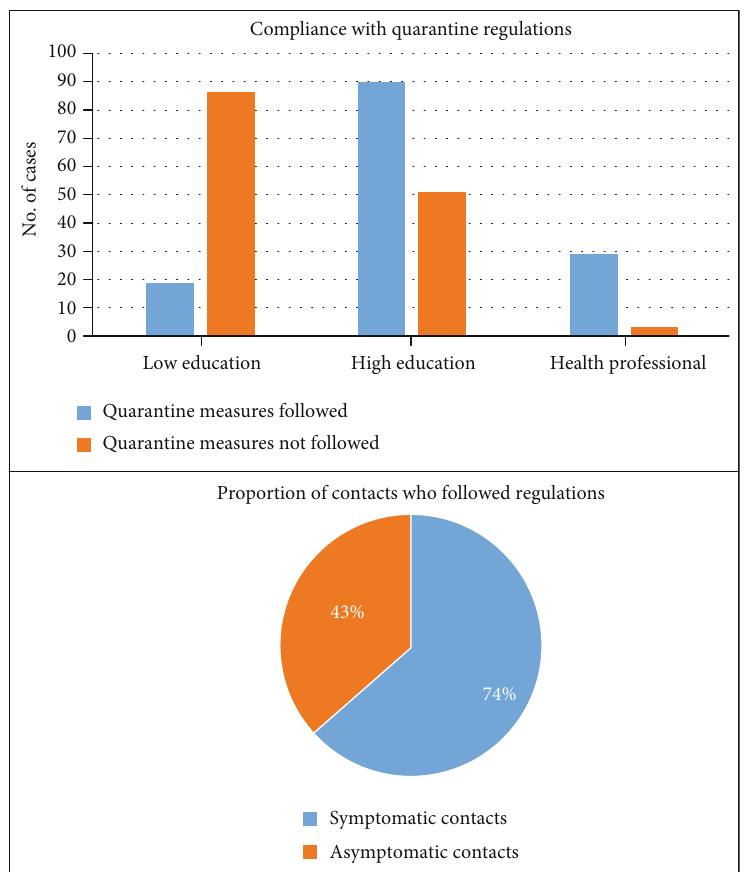
Figure 3: An overview of the compliance with quarantine regulation. Parents of the contacts with higher education and in the health profession and the families of symptomatic contacts reported better compliance with quarantine regulations ( p ≤ 0 : 01